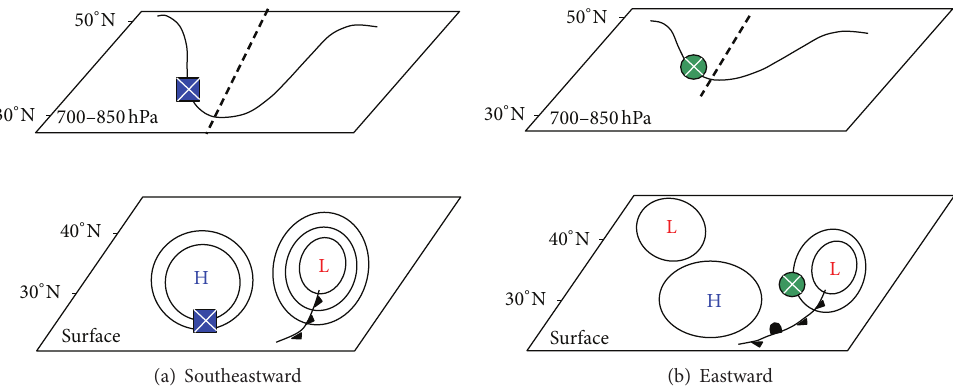
Figure 10: Schematic diagram showing the locations of the traced dust parcels (circle or square with x) relative to synoptic maps in the lower troposphere and at surface for (a) southeastward- and (b) eastward-moving events. Lower-level trough (heavy dash line) and surface front (solid line with triangle) are plotted. High- (H) and low- (L) pressure systems are